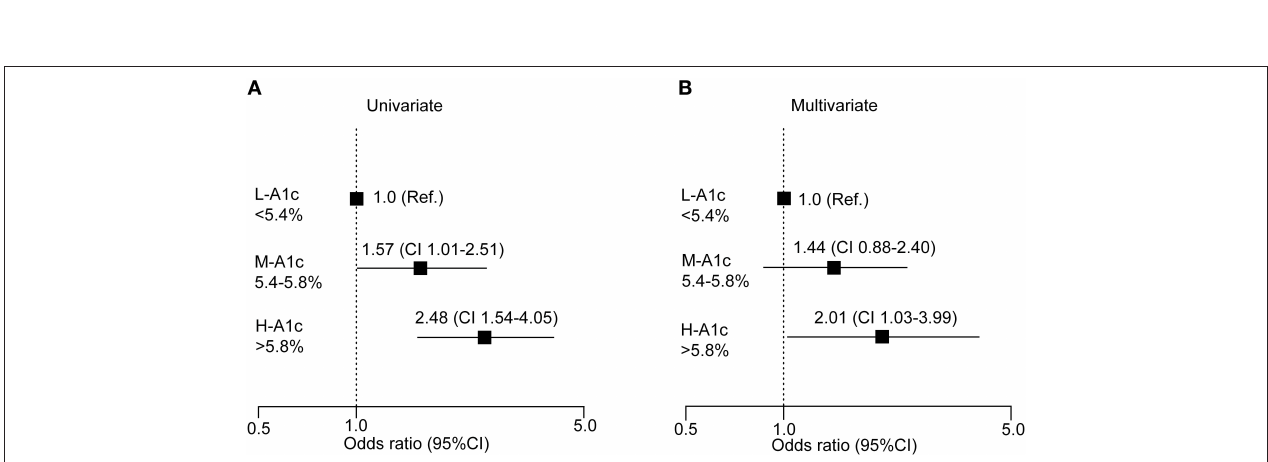
FIGURE 4 | Logistic analysis of clinical measures at risk for increased P-IES. Odds ratio with 95% confidence interval (CI) for HbA1c (A,B) are shown. Multiple factors are age, BMI, waist circumference, decreased ATR, FBS, sBP, and hypertension. Ref: reference. L-A1c: HbA1c low, M-A1c: HbA1c moderate, H-A1c: HbA1c high.